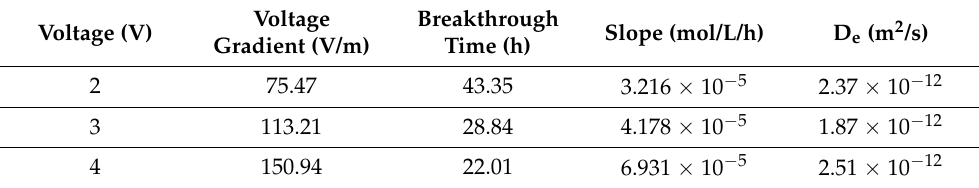
Table 7. Electromigration experimental results with ideal plug-flow modeling of Cs + migration through the rock